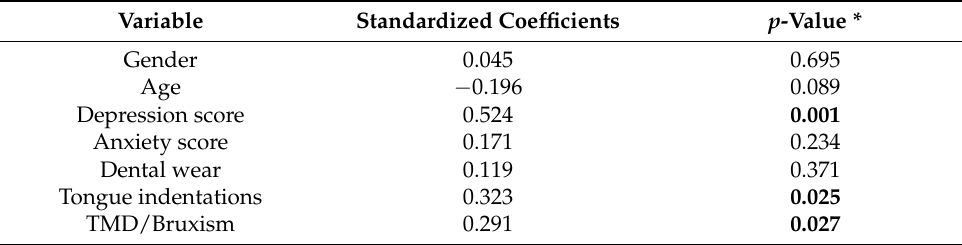
Table 4. Model summary and coefficients for THI score